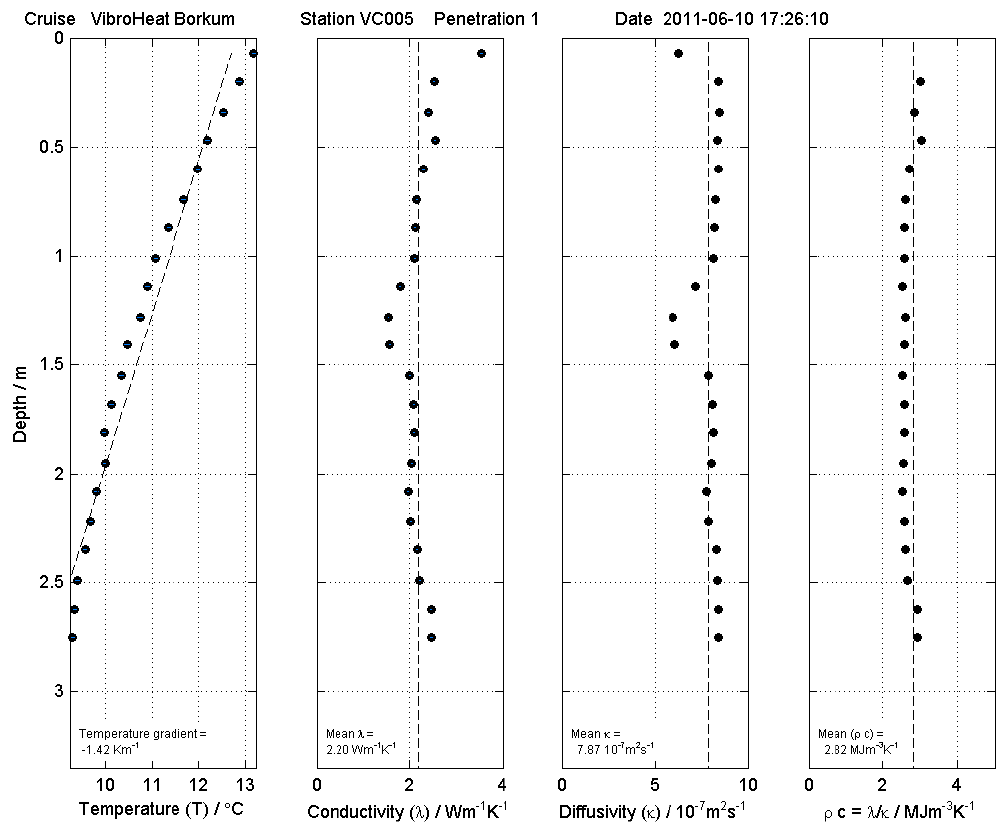
Figure 3. Results of a VibroHeat survey in the North Sea north of Borkum in 2011 showing in situ temperature, thermal conductivities, thermal diffusivity, and volumetric heat capacity as a function of